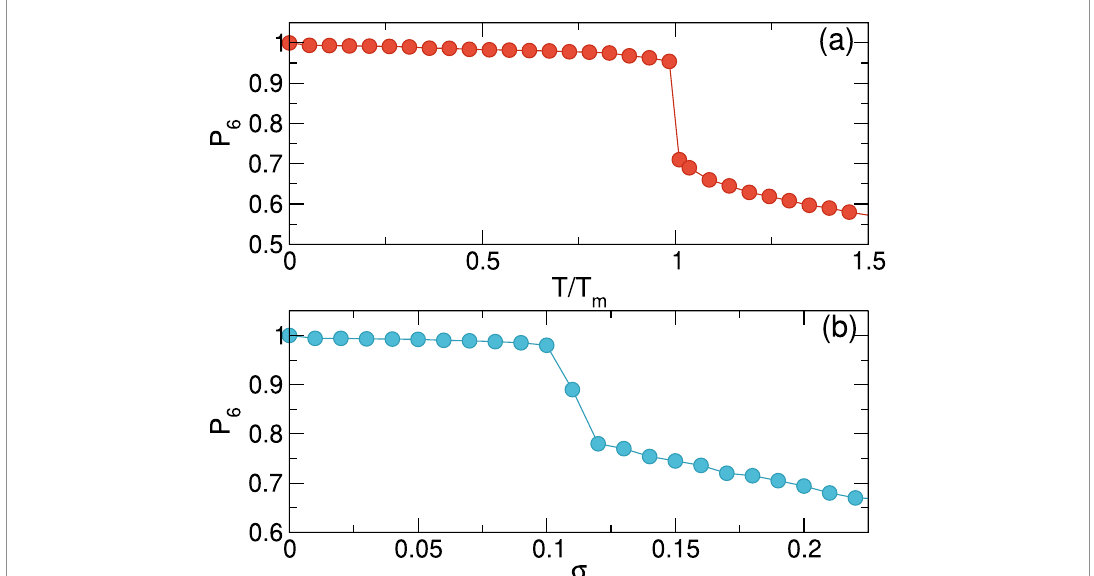
Figure 2. (a) The fraction of sixfold coordinated electrons P 6 vs reduced temperature T / T m for a system with no quenched disorder, σ = 0. There is a well defined melting temperature T m indicated by the drop in P 6 . (b) P 6 vs disorder strength σ in a system with pinning density n p = 0 . 25 and zero temperature, T / T m = 0. There is a well defined value of σ , σ c , at which topological defects begin to proliferate, leading to a drop in P 6 .